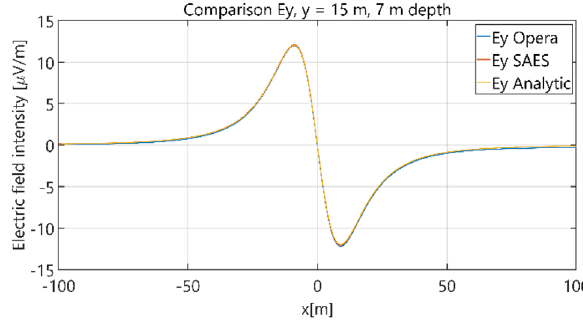
Figure 22. Distribution of E y component ( y = 15 m, z = − 7 m, case II).